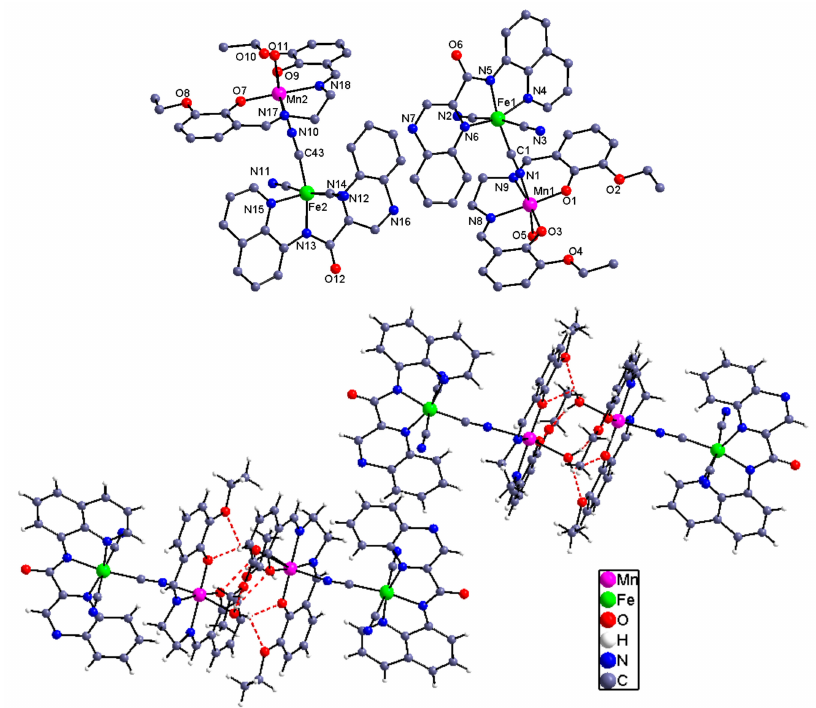
Figure 3. Molecular view of 3 with the selected atom-labeling scheme and its H-bond interaction resulting supramolecular dimeric structure. The solvent contents have been omitted for